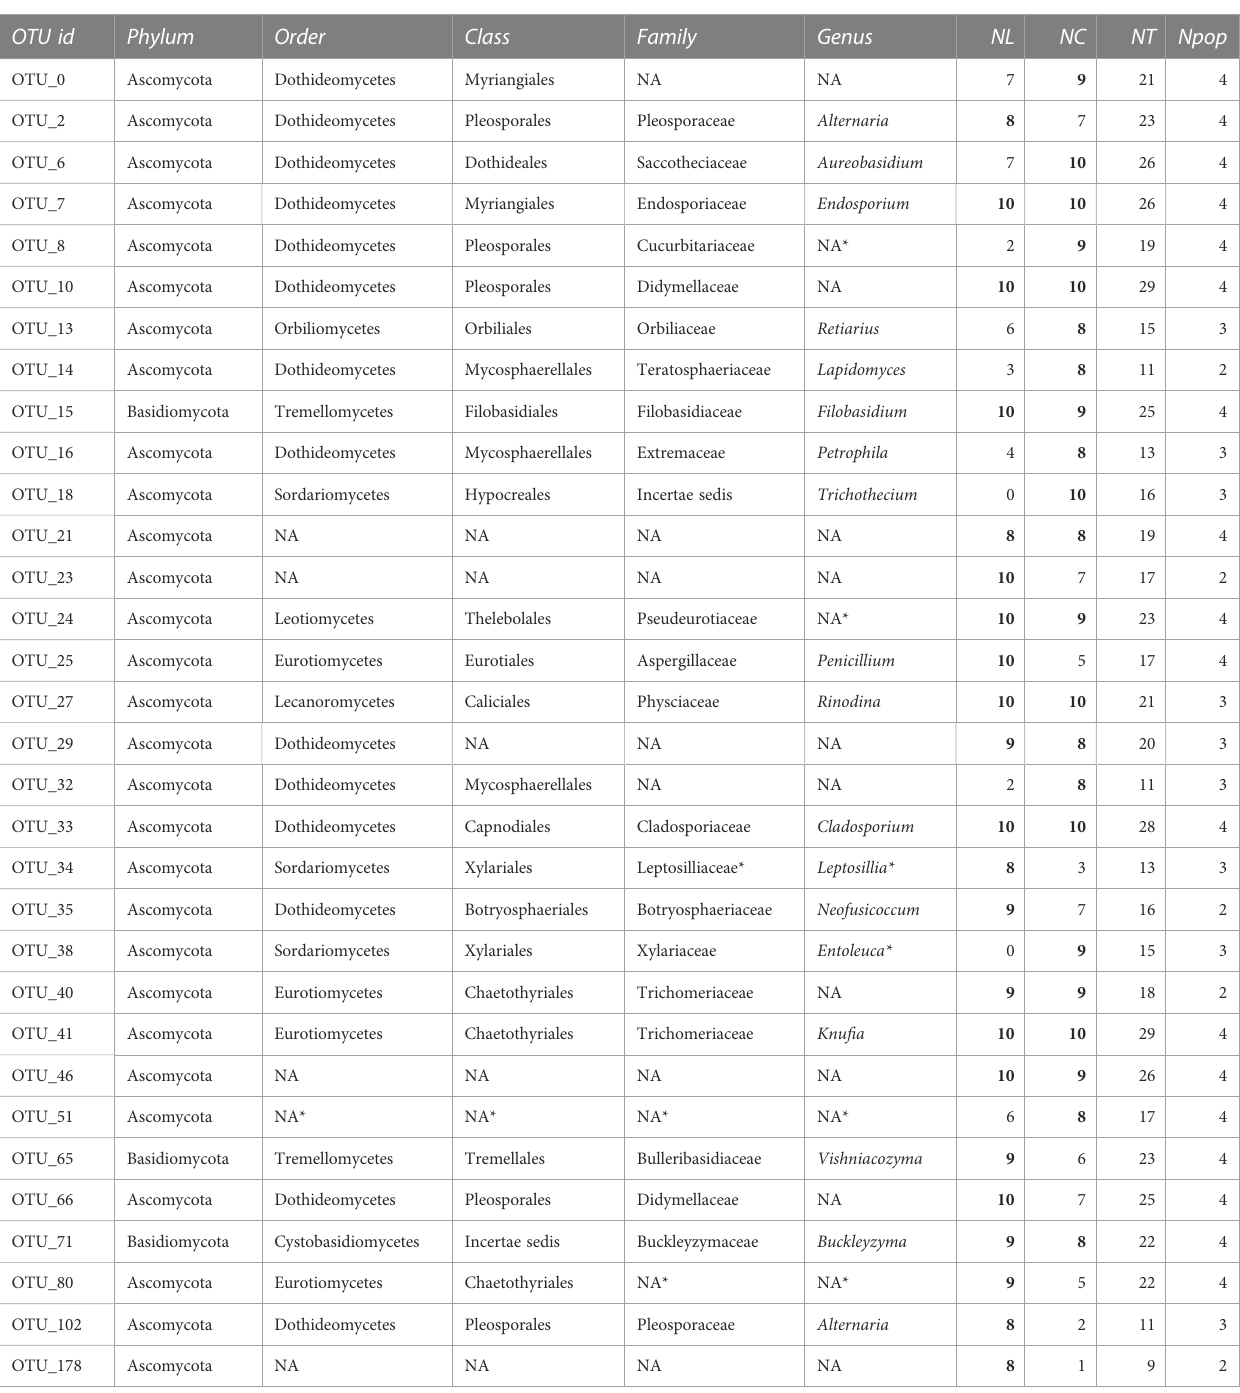
TABLE 1 OTUs present in at least eight samples of the landmark tree or the clonal